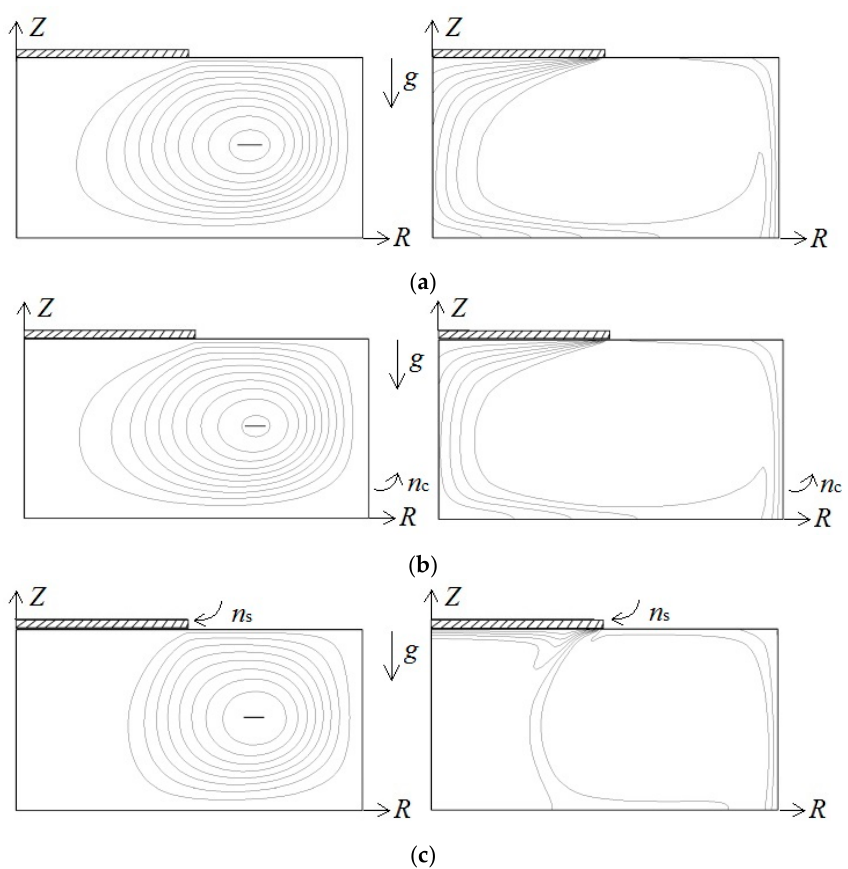
Figure 2. The streamlines (left) and iso-concentration lines (right) at Re T = 2 × 10 3 , δΦ = 0.1. ( a ) Re c = Re s = 0, ψ = 46.8, Re = 0, ψ = 0, Re = − 467.5, ψ − ) = 16.4; ( b ) Re − ) = − 16.1; ( c ) Re − ) = − = 0, ψ max ( − ) = 16.4; ( b ) Re c = 46.8, Re s = 0, ψ max ( − ) = − 16.1; ( c ) Re c = 0, Re s = − 467.5, ψ max ( − )= − 15.8. max ( c s max ( c s max (